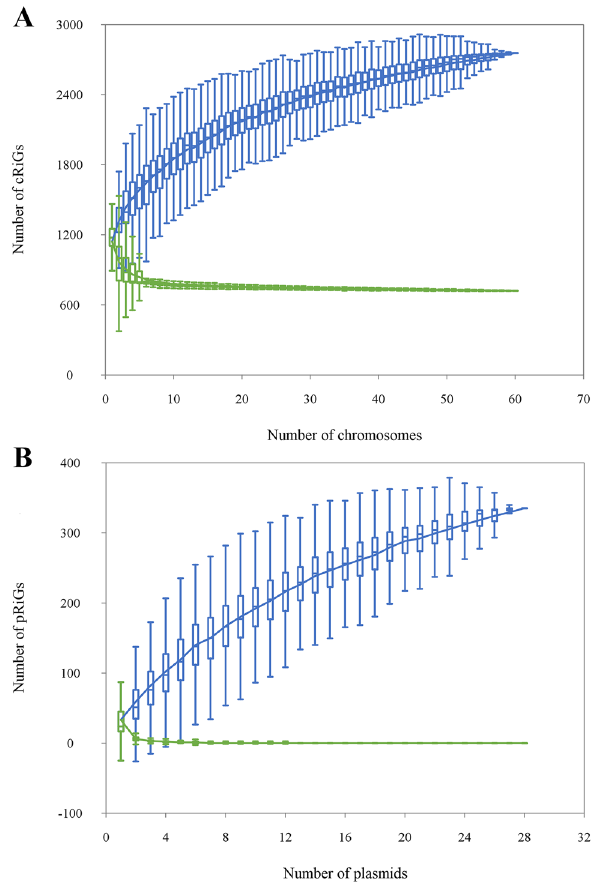
Figure 3. Estimation of the core chromosome (y = 497 e −0.312x + 737; R 2 = 0.95) and pan-chromosome (y = 1029 x 0.23 + 87; R 2 = 0.99) established through the analysis of 60 complete chromosomes of 28 Rickettsia spp. ( A ). Estimation of the core plasmidome (y = 144.2 e −1.48x + 0.36; R 2 = 0.99) and pan-plasmidome (y = 100.7 x 0.42 —74.3; R 2 = 0.99) simulated from 27 complete plasmids representing 15 Rickettsia spp. ( B ). Box plots show the median and